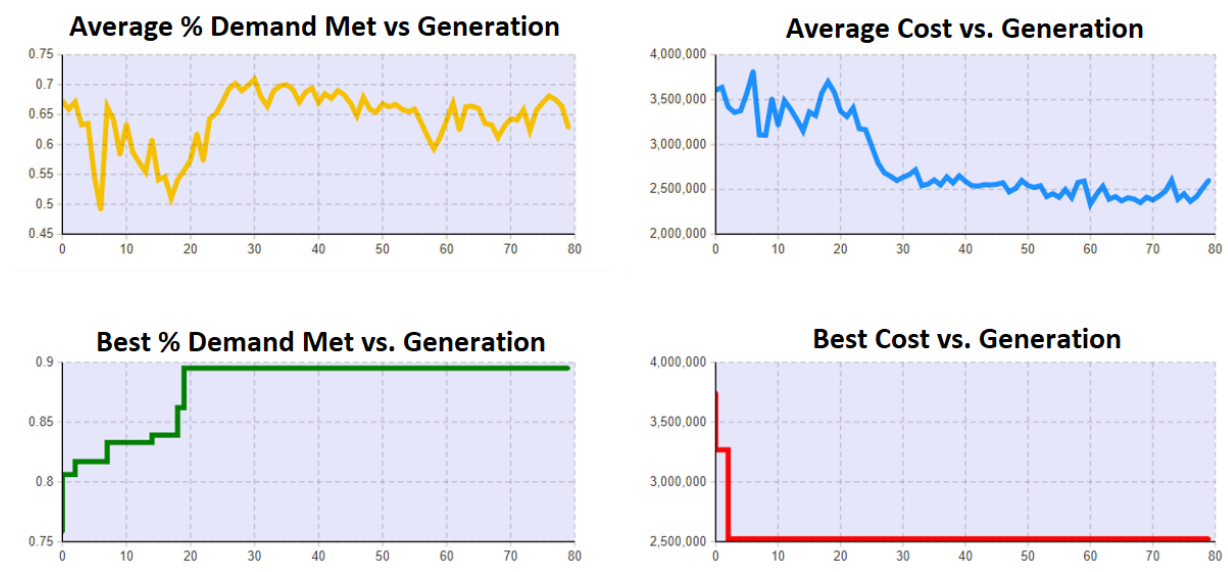
Figure 4. The large problem’s minimal cost and maximal demand met progress by